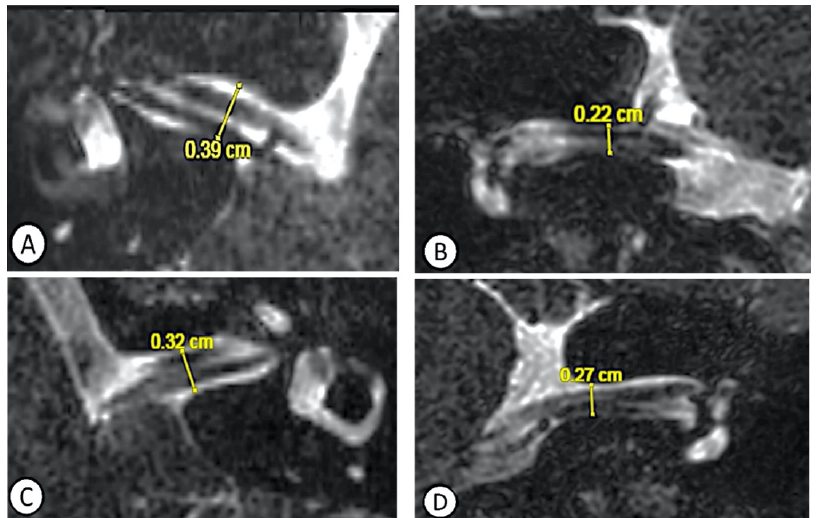
Figure 1. MRI of the inner ear (IAC sections) suggesting a bilateral narrowing of the IAC in the coronal plane, more pronounced on the right side: ( A ) right ear, axial plane; ( B ) right ear, coronal plane; ( C ) left ear, axial plane; and ( D ) left ear, coronal plane. caudal diameter was estimated at 2.3 and 2.7 mm on the right and left side, respectively (Figure 2).